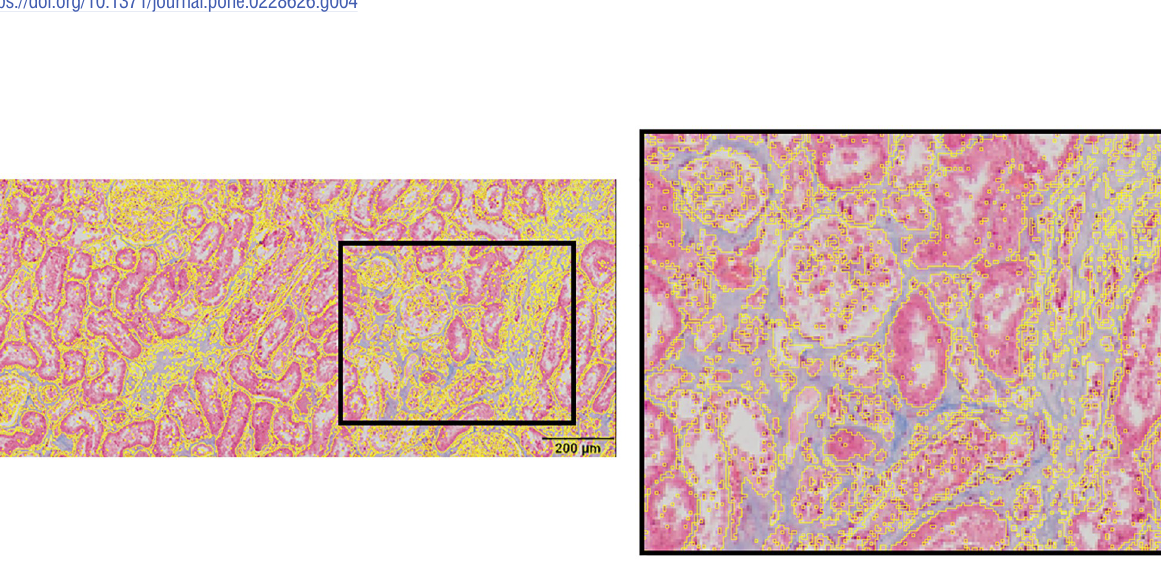
PLOS ONE | https://doi.org/10.1371/journal.pone.0228626 February 13,